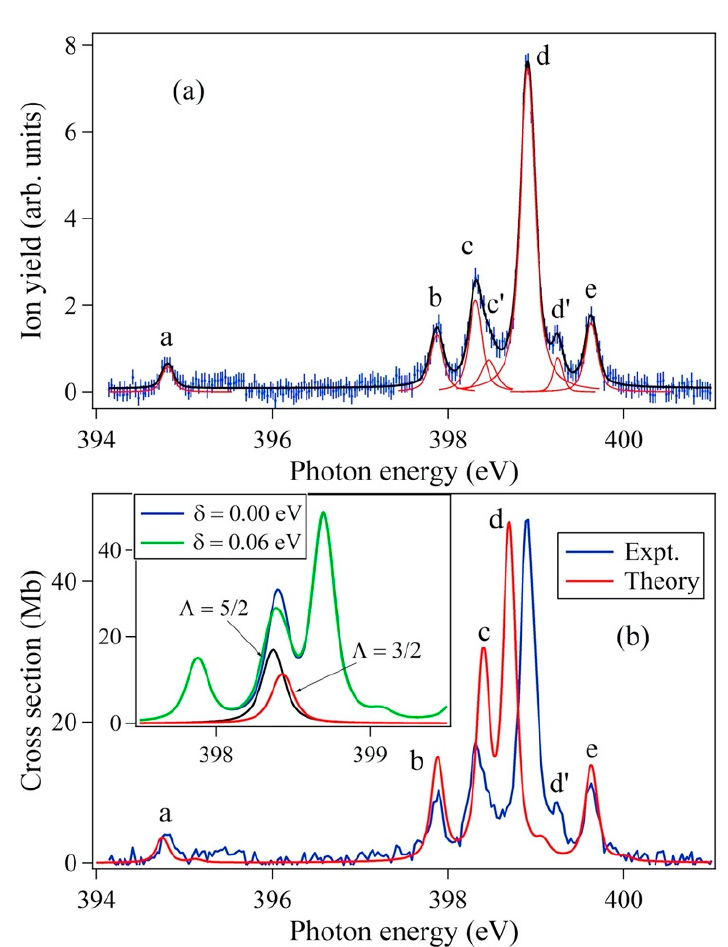
Figure 3. ( a ) Fitting by Voigt profiles of the experimental data, ( b ) NH+ experimental (blue trace Expt.) and calculated (red trace Theory) X-ray absorption spectra (XAS). The most important features are labeled (see Table 2). The experimental spectrum has been normalized to the maximum of peak d. In the insert is shown the splitting of the 2 ∆ states components (peak c) due to spin-orbit coupling for two δ values (see text).